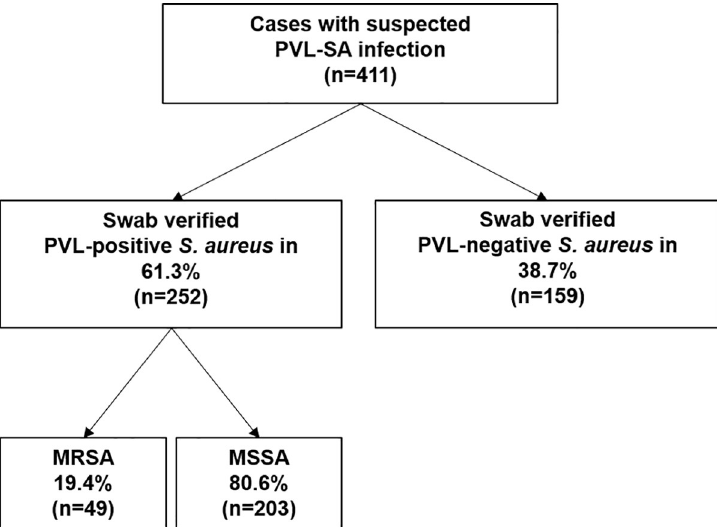
Fig 2. Overview recruitment pathogen perspective. PVL-SA isolated, stratified by methicillin-resistance (MRSA) and methicillin-susceptibility (MSSA). PVL, Panton-Valentine leukocidin. SA, Staphylococcus aureus .